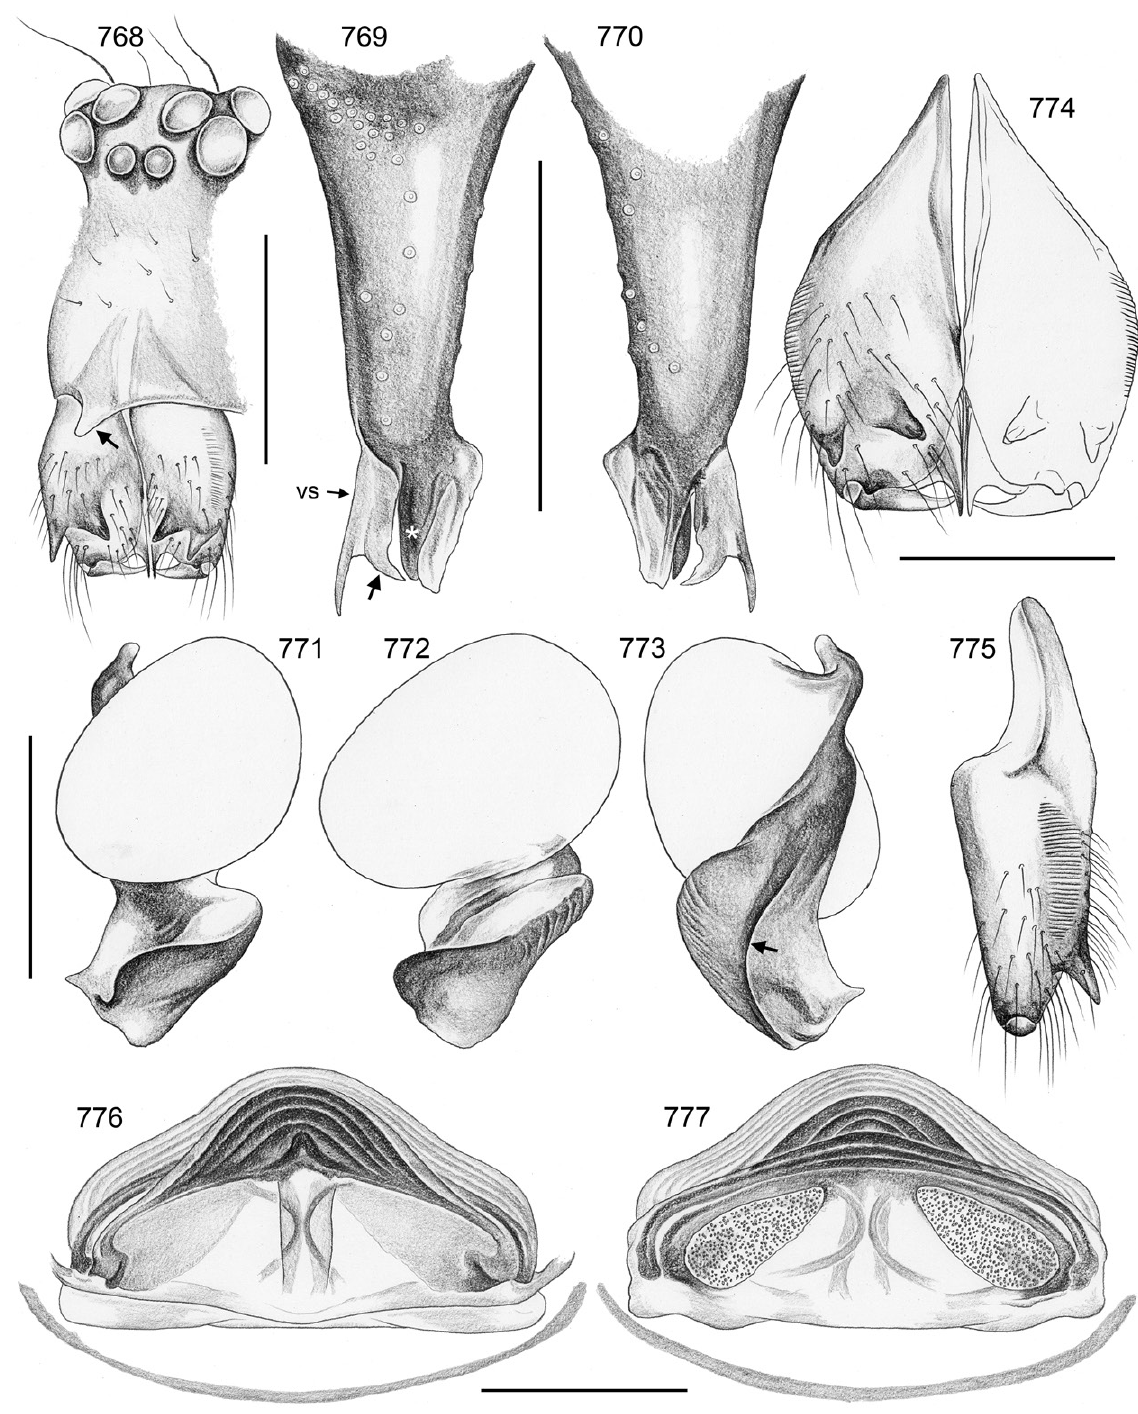
Figs 768–777. Crossopriza sengleti sp. nov.; non-type male and female from Iran, Fars, Seridjan (MHNG). 768 . Male ocular area, clypeus, and chelicerae; arrow: clypeus process. 769–770 . Left procursus, prolateral and retrolateral views; arrow: branch of ventral sclerite; asterisk: distinctive prolateral apophysis. 771–773 . Left genital bulb, prolateral, dorsal, and retrolateral views; arrow: retrolateral ridge. 774–775 . Male chelicerae, frontal and lateral views. 776–777 . Cleared female genitalia, ventral and dorsal views. Scale bars: 768 = 0.5 mm; 769–777 = 0.3